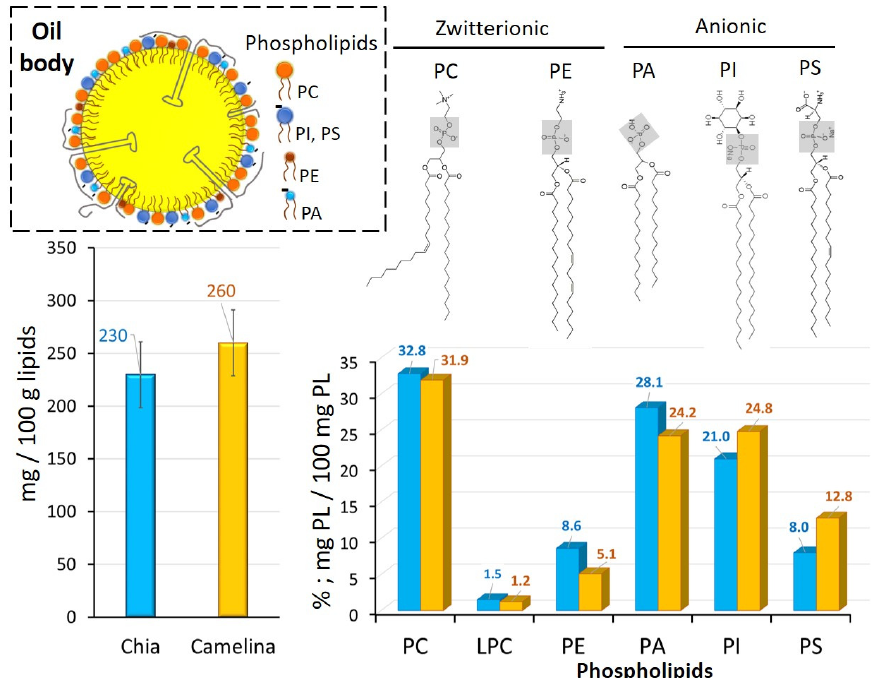
Figure 4. Phospholipid composition of chia and camelina seed oil bodies (OBs). Total phospholipid amounts and relative percentage of the main individual phospholipids. Schematic representation of an oil body enveloped by the monolayer of phospholipids (top left). The chemical structures of the main phospholipids are indicated in the figure (top right). Abbreviations: PC: phosphatidylcholine, LPC: lyso-phosphatidylcholine, PE: phosphatidylethanolamine, PA: phosphatidic acid, PI: phosphatidylinositol, PS: phosphatidylserine.